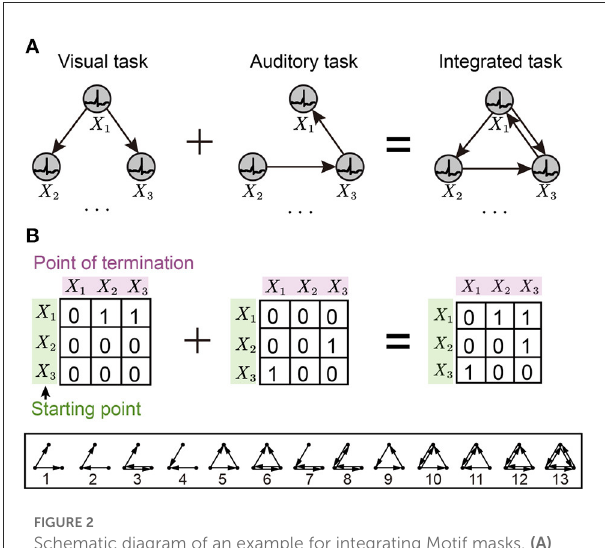
FIGURE2 Schematic diagram of an example for integrating Motif masks. (A) Schematic for Motifs of the M-SNN. (B) Schematic for Motif masks of the